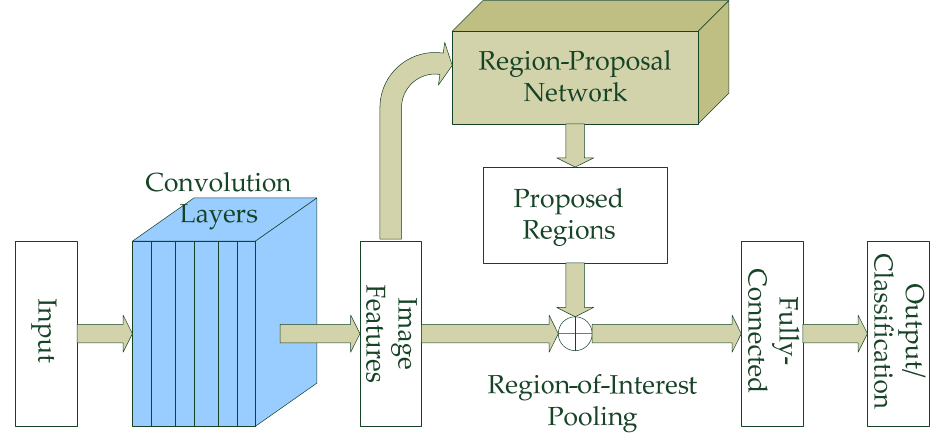
Figure 6. The block diagram of a faster-R-CNN network.